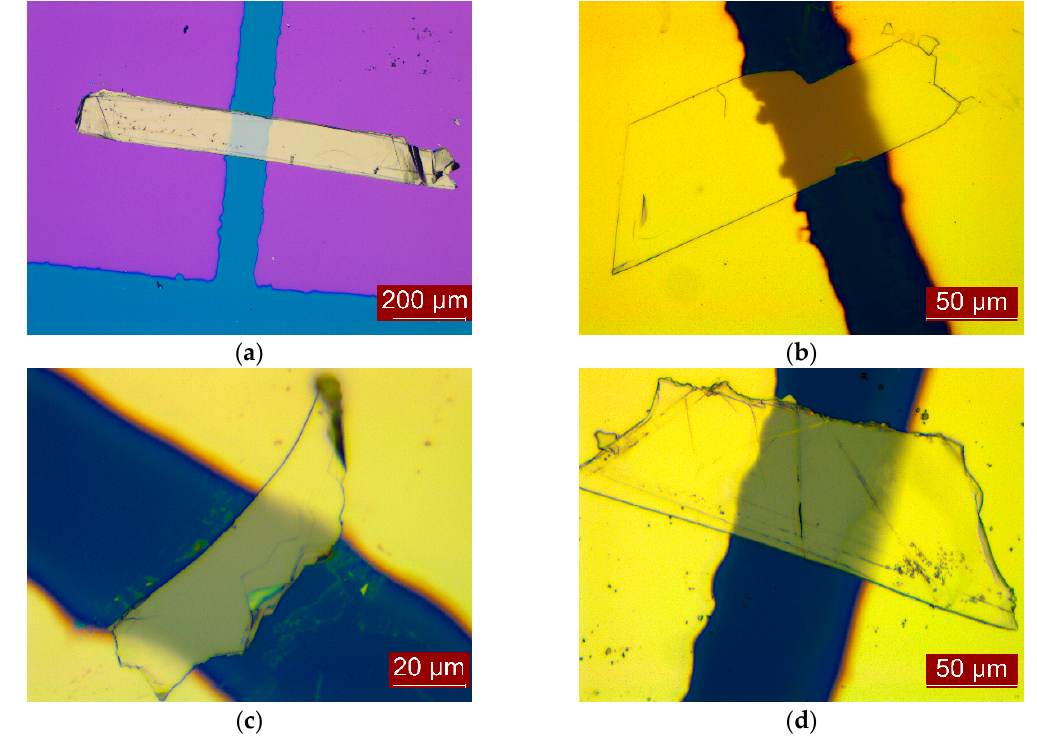
Figure 2. Molybdenum disulfide (MoS 2 ) FET devices structure.